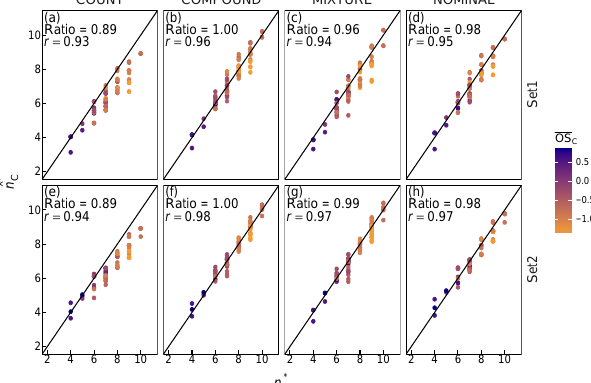
Figure 8. Comparison of estimated ( ˆ n ∗ measurable carbon atoms in different SVOC compounds (colored by their compound-averaged oxidation states, OS C ) using estimates of ˆ λ C for various FG sets and solution methods. The diagonal line is the x = y line provided for visual reference. The ratio is defined /n ∗ as ˆ n ∗ and estimated as the slope (not drawn) of ˆ n ∗ C C on n ∗ . r is the Pearson’s correlation coefficient. C